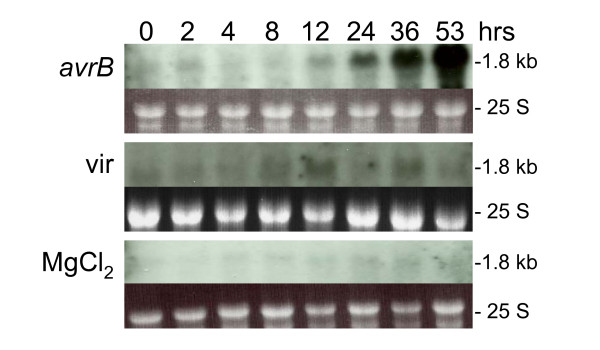
Flavonoid 3'-hydroxylase (F3'H) RNA (1.8 kb) profile. Measurements made at 8 intervals through a 53 hr period in response to infection by Pseudomonas syringae pv glycinea with avrB (avrB) or without (vir) (First and second panels respectively). Third panel is the F3'H RNA profile in response to infiltration with control medium (MgCl2). Dark background sub-panels are the 25 S ribosomal RNAs from corresponding ethidium bromide-stained gels prior to membrane transfer and shown to compare sample loading. Gm-c1019-10961 soybean cDNA clone was used as probe.